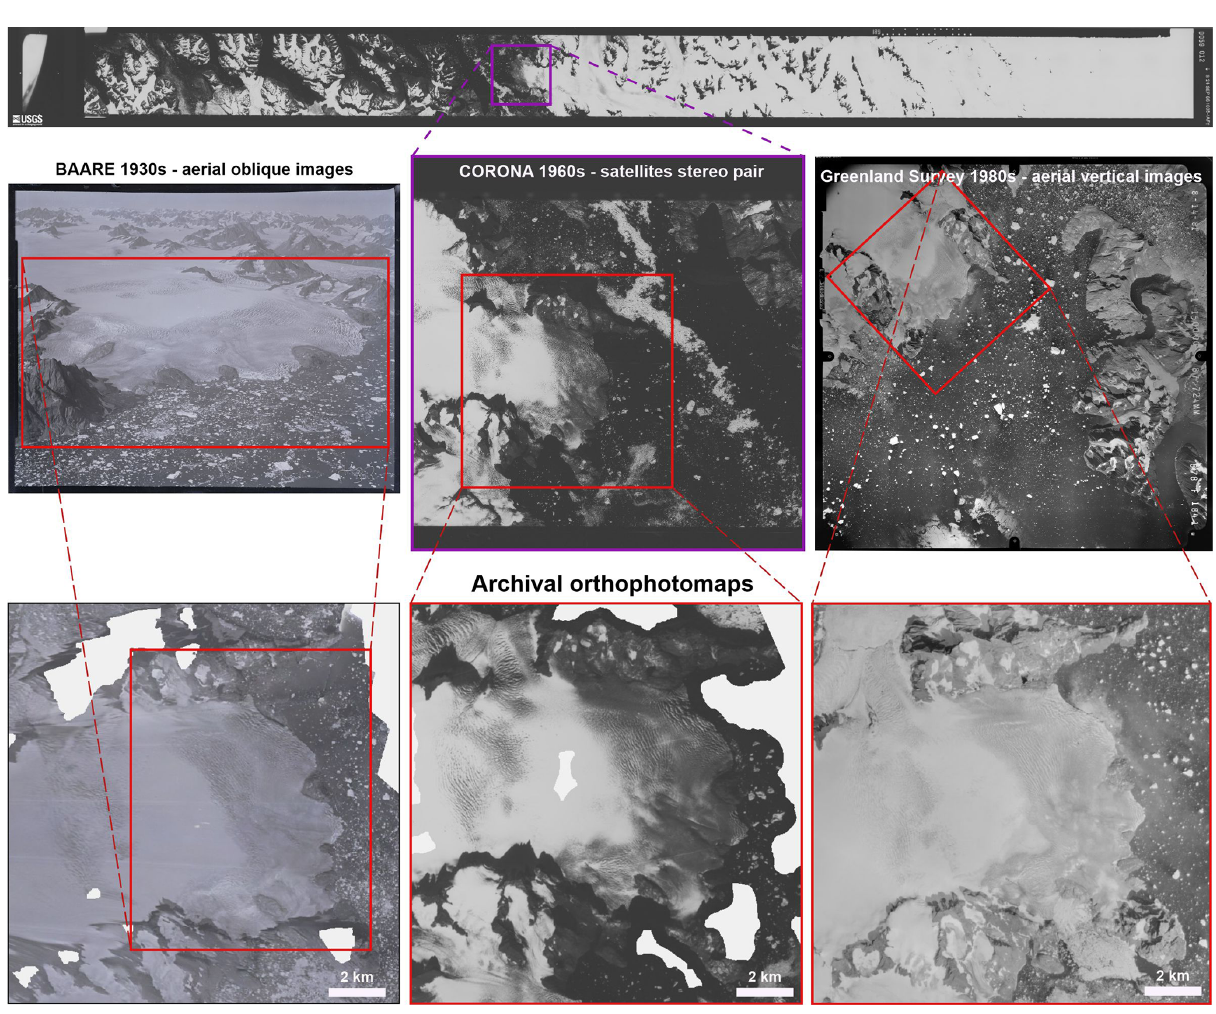
Figure 2. Illustration of typical source data and SfM-based orthophotomaps for archival image datasets. We show the BAARE (col. 1), CORONA (col. 2) and Greenland survey (col. 3) datasets. For BAARE and Greenland survey, we show source images in the second row. The CORONA images cover such a large area that we show a complete strip in the top row, then a region crop in the second. Our derived orthopho- tomaps are shown in the third row with the approximate correspondence to source images shown in red. The CORONA dataset was obtained via USGS EarthExplorer (Declassified Satellite Imagery – 1; DOI: https://doi.org/10.5066/F78P5XZM; Earth Resources Observation and Science Center,